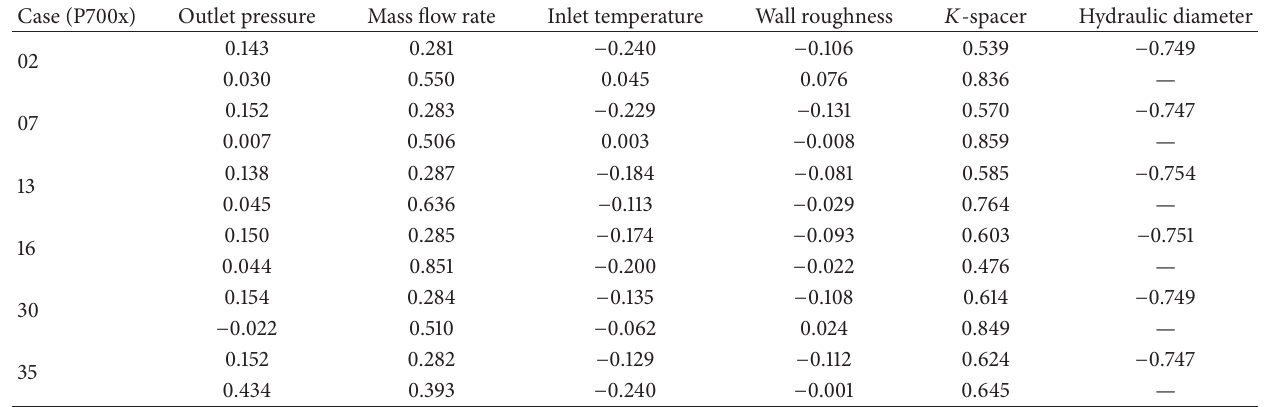
Table 4: Sensitivity coefficients for the single-phase flow pressure drop.